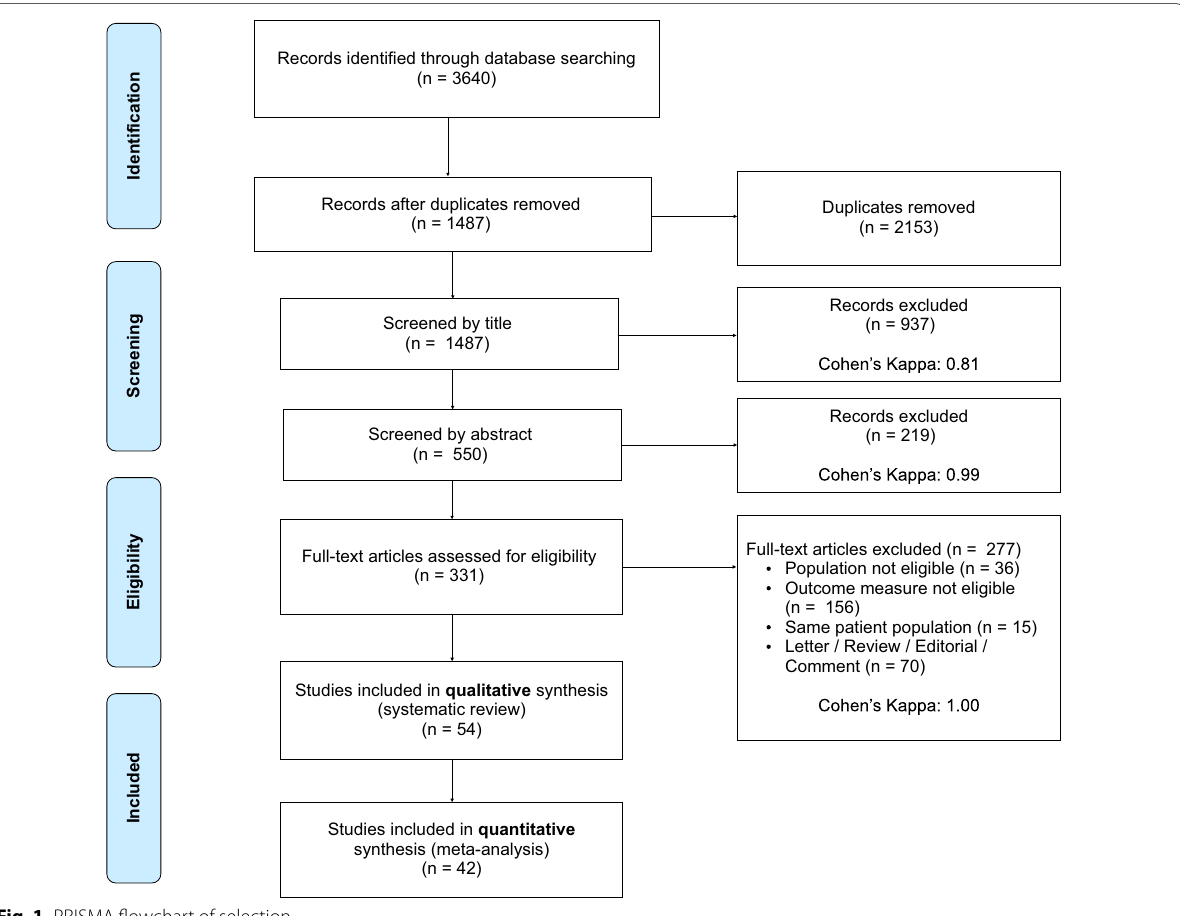
Fig. 1 PRISMA flowchart of